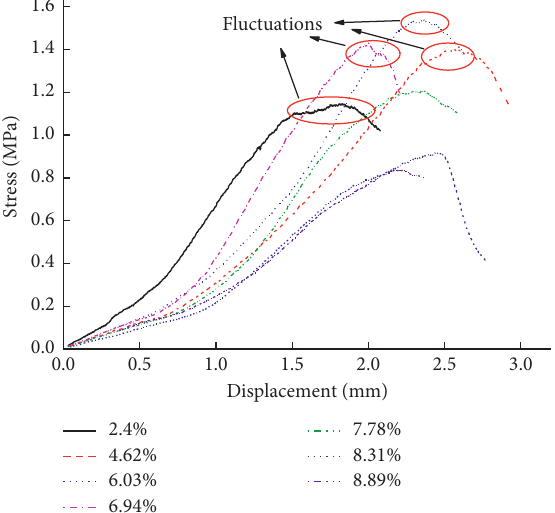
Figure 4: Stress-displacement curves of 28d age.